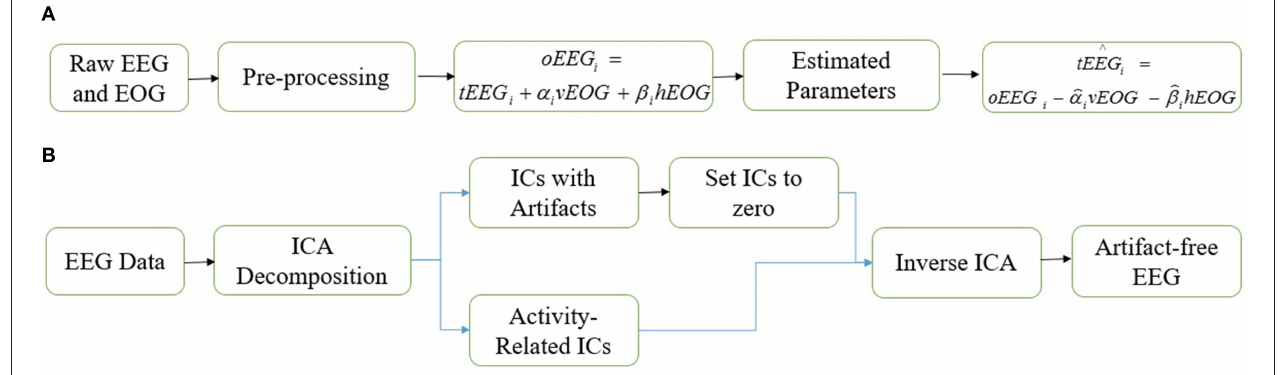
FIGURE 1 | Schematic diagrams. (A) Regression method. (B) Independent component analysis.